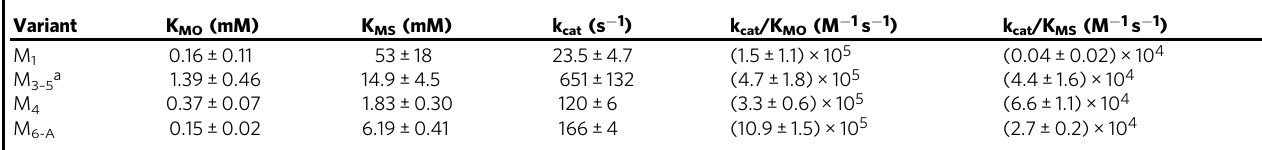
Table 3 Kinetic parameters of GOase variants determined in the TiTR with HMF.